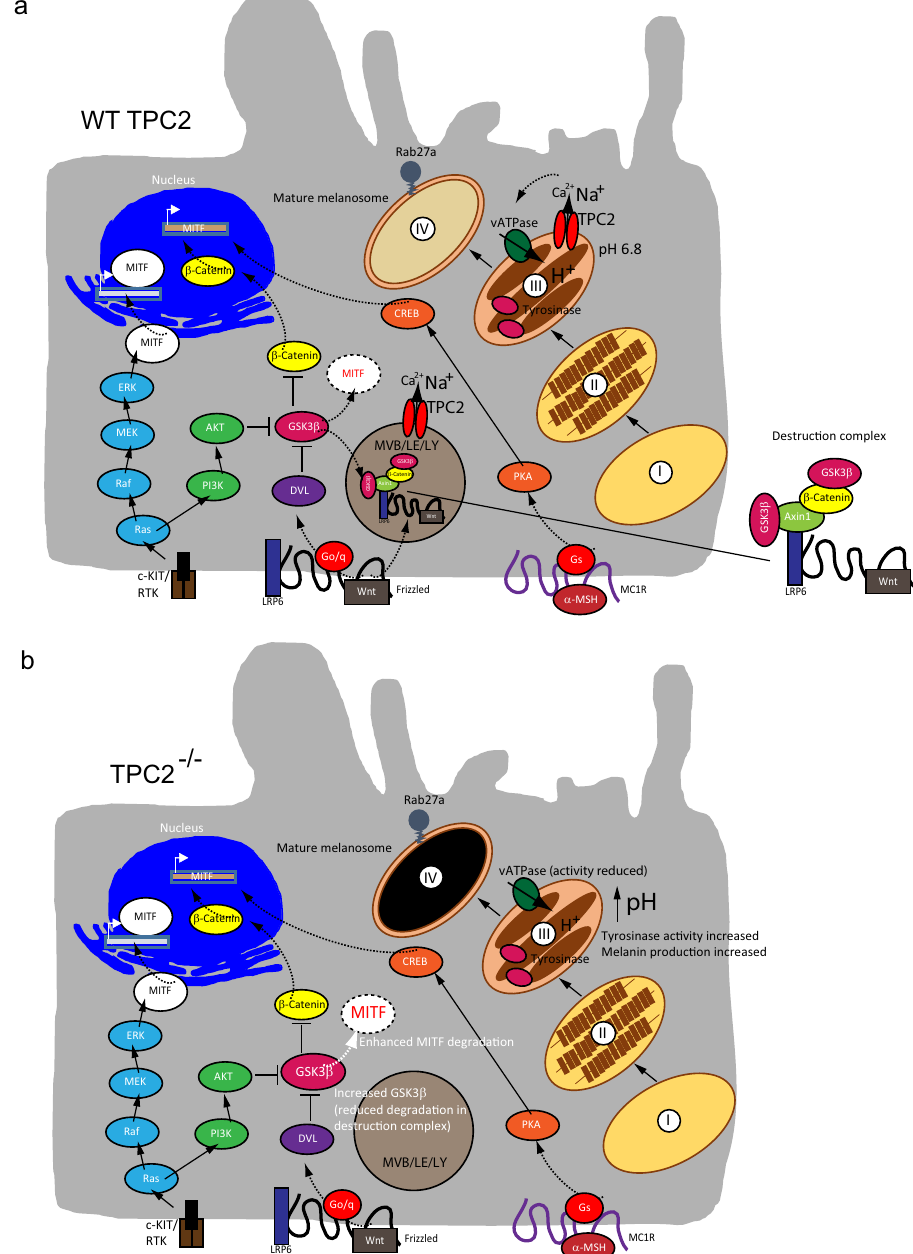
Figure 7. MITF signalling pathways and proposed effects in TPC2 knockout melanoma cells. ( a ) and ( b ) Cartoons showing MITF signalling pathways in WT ( a ) and TPC2 −/− cells ( b ). Several pathways regulate MITF expression: RAS/RAF/MEK/ERK, PI3K/AKT, Wnt/GSK3β/β-Catenin, and MSH/CREB signalling pathways. GSK3β is a negative regulator of MITF expression and promotes proteasomal degradation of MITF. GSK3β degradation in endolysosomes is enhanced by Wnt signalling. Tyrosinase activity depends on melanosomal pH and is regulated by TPC2 activity in melanosomes. Loss-of-function of TPC2 in endolysosomes and melanosomes results in increased GSK3β and decreased MITF protein levels as well as increased tyrosinase activity and melanin